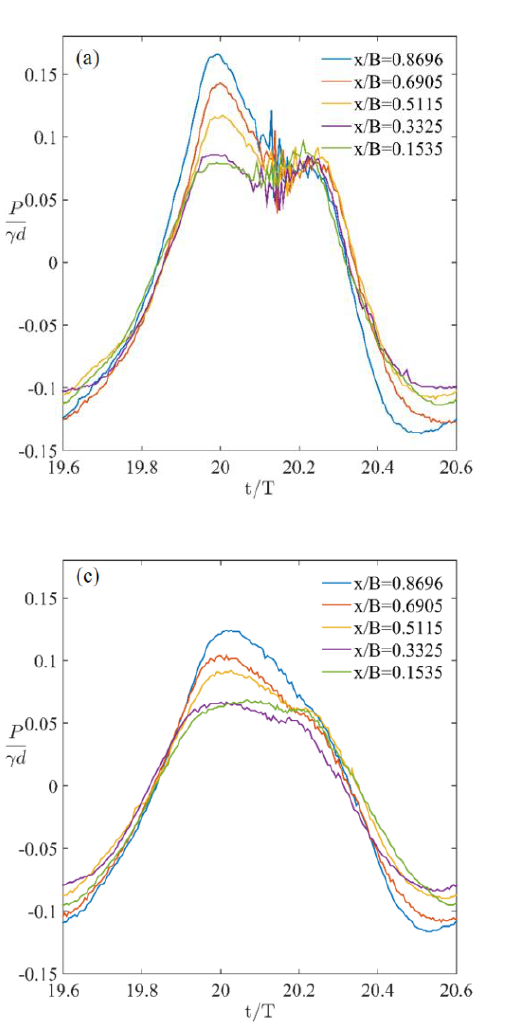
Figure 8. Time series of dynamic wave pressure below caisson under three wave steepness conditions: H/L = ( a ) 0.0468; ( b ) 0.0425; and ( c ) 0.0383.